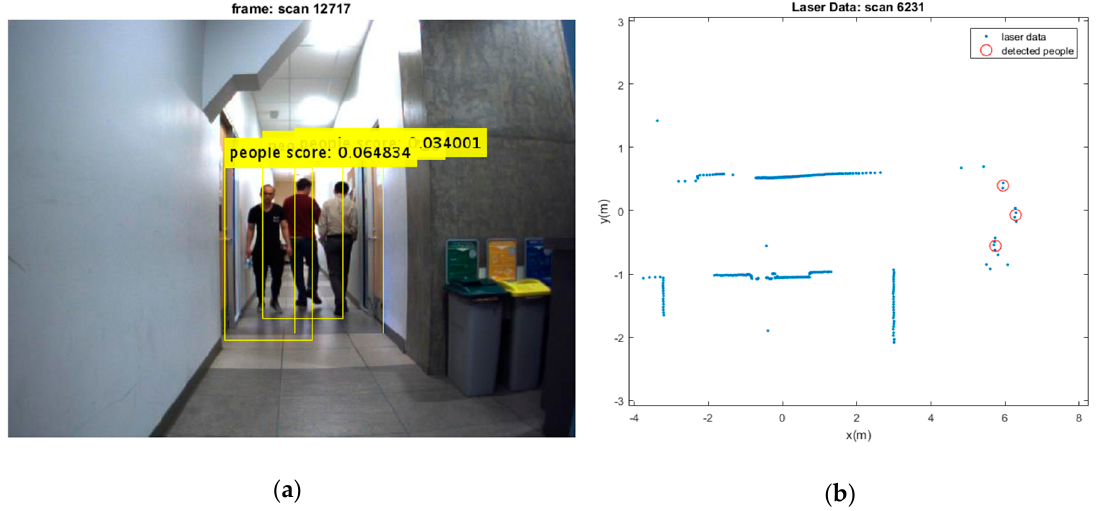
Figure 6. ( a ) Three detected moving people; ( b ) Their extracted depth from laser sensor.